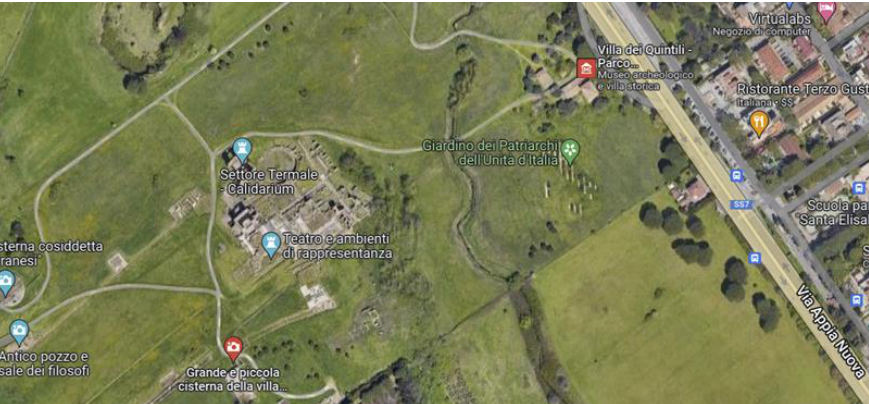
Figure 18. Aerial view of the Villa of the Quintili in the Appia archaeological park (from Google Maps). The Calidarium building can be seen in the central area. The yellow line indicates Via Appia Nuova, the closest modern highway (on the right).